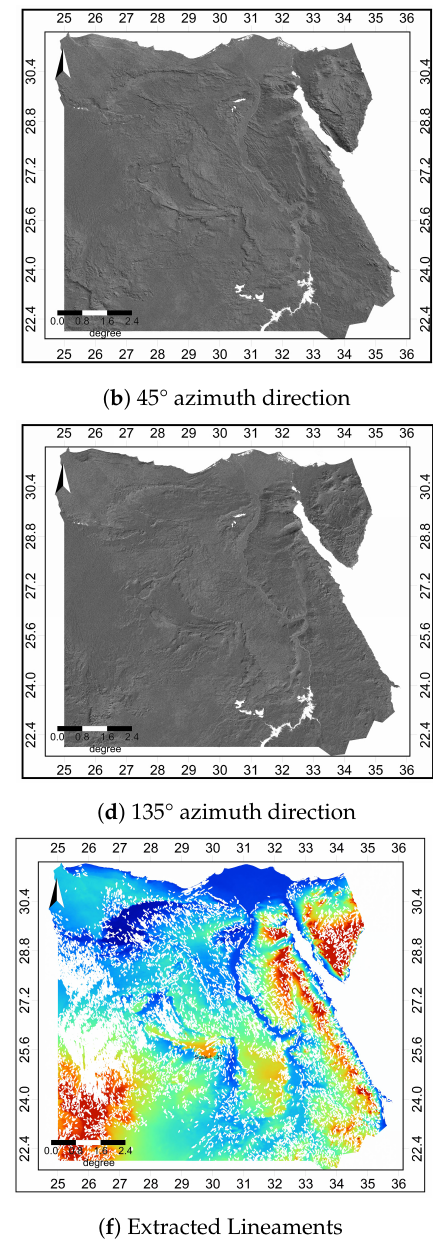
Figure 6. Enhanced shaded-relief images generated from a DEM: ( a ) for azimuth direction of 0°; ( b ) for 45°; ( c ) for 90°; ( d ) for 135°; ( e ) for automatic lineament mapping, ( f ) automatic extracted